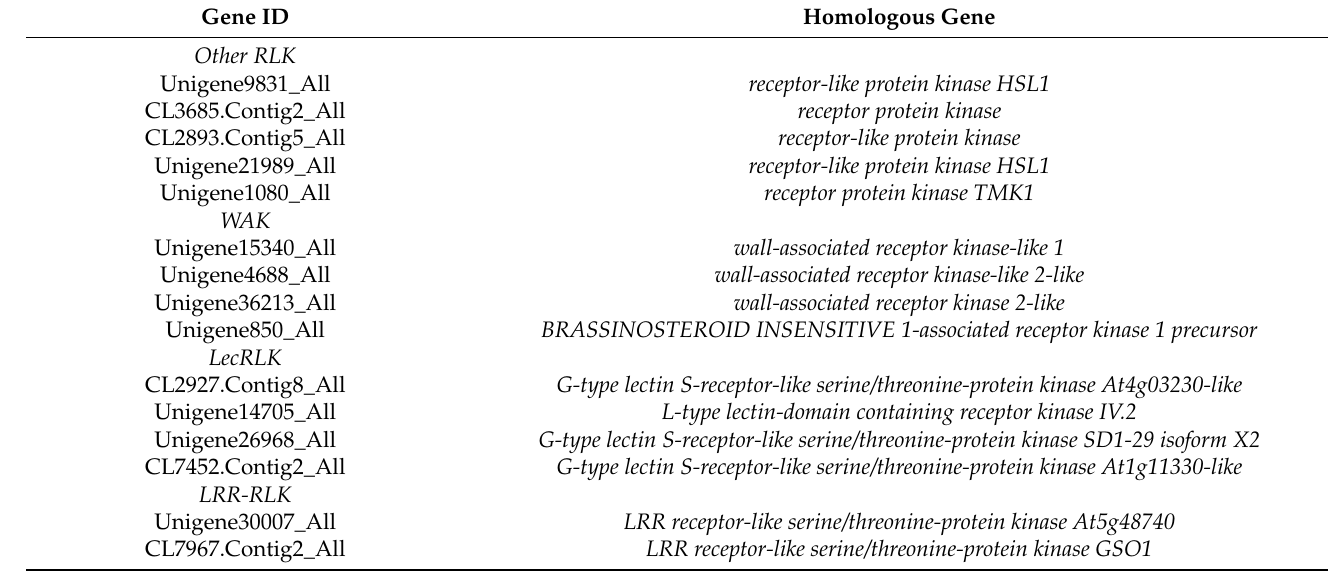
Table 17. The upregulated DEGs related to protein kinases in the roots of A. canescens under 100 mM NaCl for both 6 and 24 h.